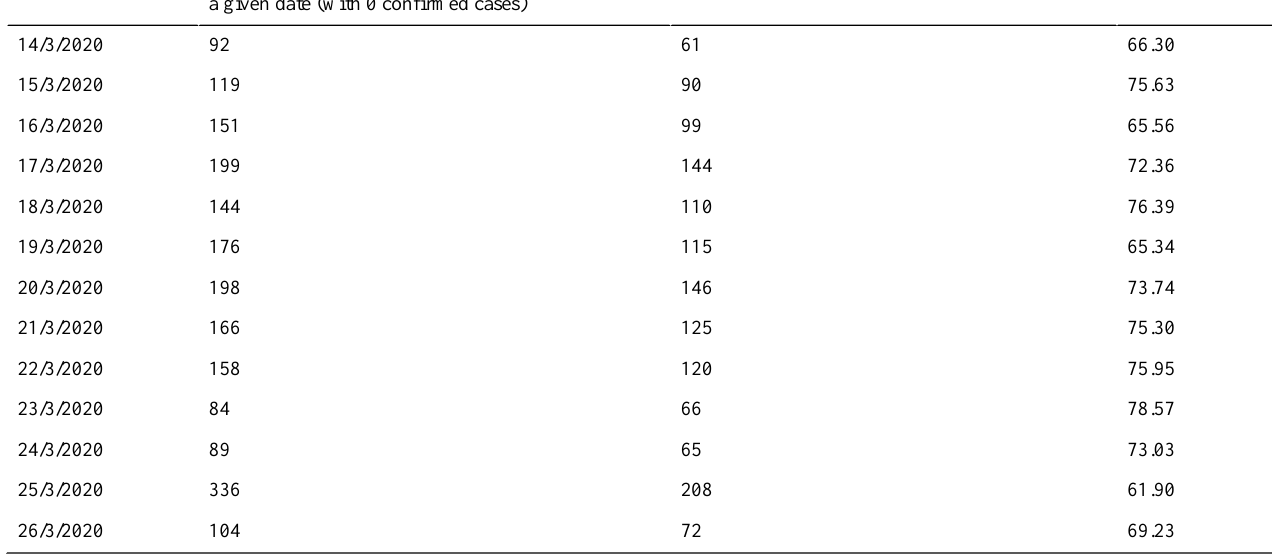
Table 2. Sensitivity of the three-stage